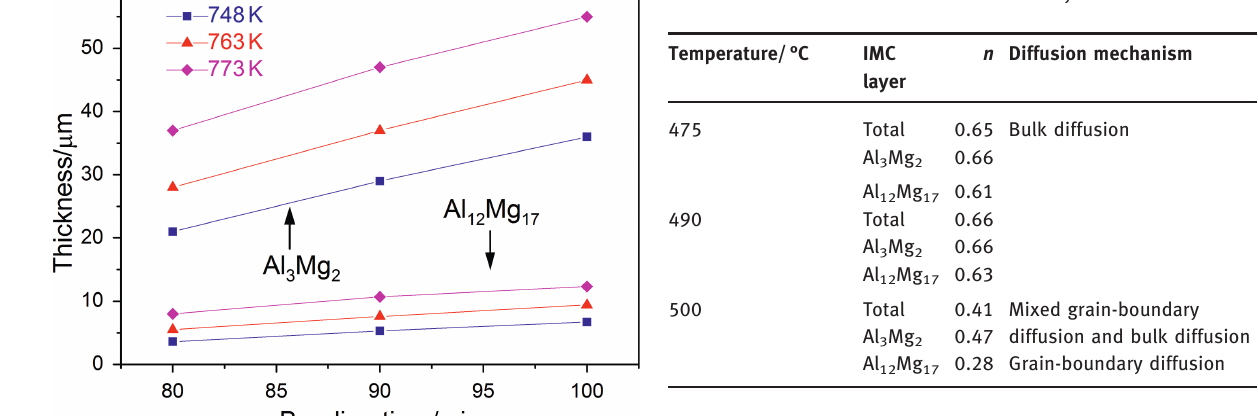
Table 2: Diffusion mechanisms for the IMC